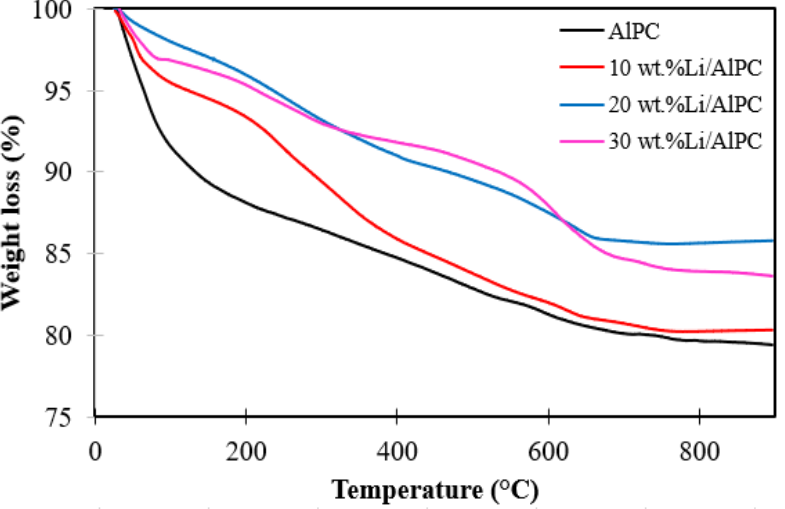
Figure 10. Thermal gravimetric analysis (TGA) graph of spent AlPC and x wt.%Li/AlPC (x = 10, 20 and 30 wt.%) catalysts at catalyst loading = 2 wt.%, reaction temperature = 200 °C.